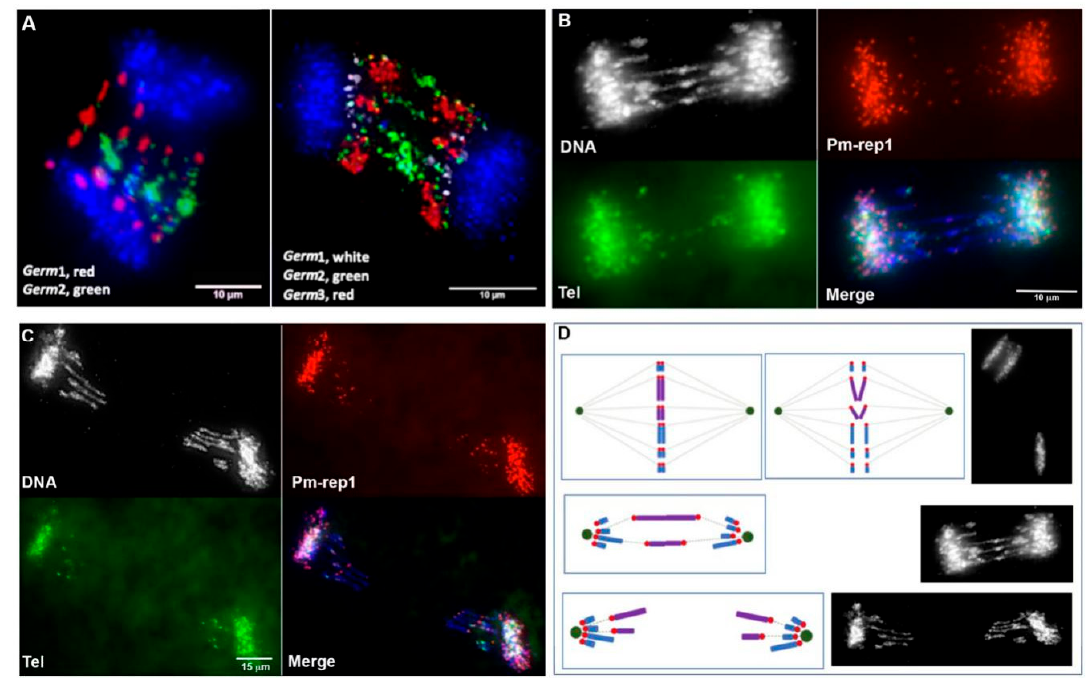
Figure 6. Chromosome lagging in anaphases from 1.5. dpf embryos, illustrating progression through anaphase and the antiparallel orientation of lagging chromosomes. ( A ) Earlier stages of anaphase chromosome separation show symmetrical hybridization patterns for germline-specific repeats. The repeat Germ1 is primarily located on the poleward ends of stretched chromosomes, which is consistent with its pericentromeric location. In contrast, the repeat Germ2 is localized to the midzone of bridging anaphases. ( B , C ) FISH of a probe for the pericentromeric repeat Pm-rep1 (red), telomere PNA probe (green), and testes genomic DNA (Cy5, shown in blue). The Pm-rep1 probe also yields fainter signals on the distal edges of lagging chromosomes which are often colocalized with distal telomeric signals. Chromatid contacts are characterized by denser DNA staining and FISH signals marking the telomeres/subtelomeres of sister chromatids which are often visible adjacent to each other (especially on panel A). Later in anaphase, ( C ) germline-specific chromosomes retain a stretched morphology and generally bear FISH signals from probes marking their edges (centromeres and telomeres). ( D ) Schematic depiction of chromosome elimination in the sea lamprey referencing features of the examples provided in panels B and C.